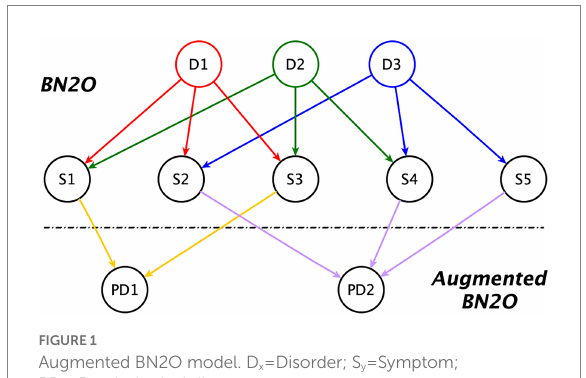
FIGURE 1 Augmented BN2O model. D x = Disorder; S y = Symptom; PD z = Psychological